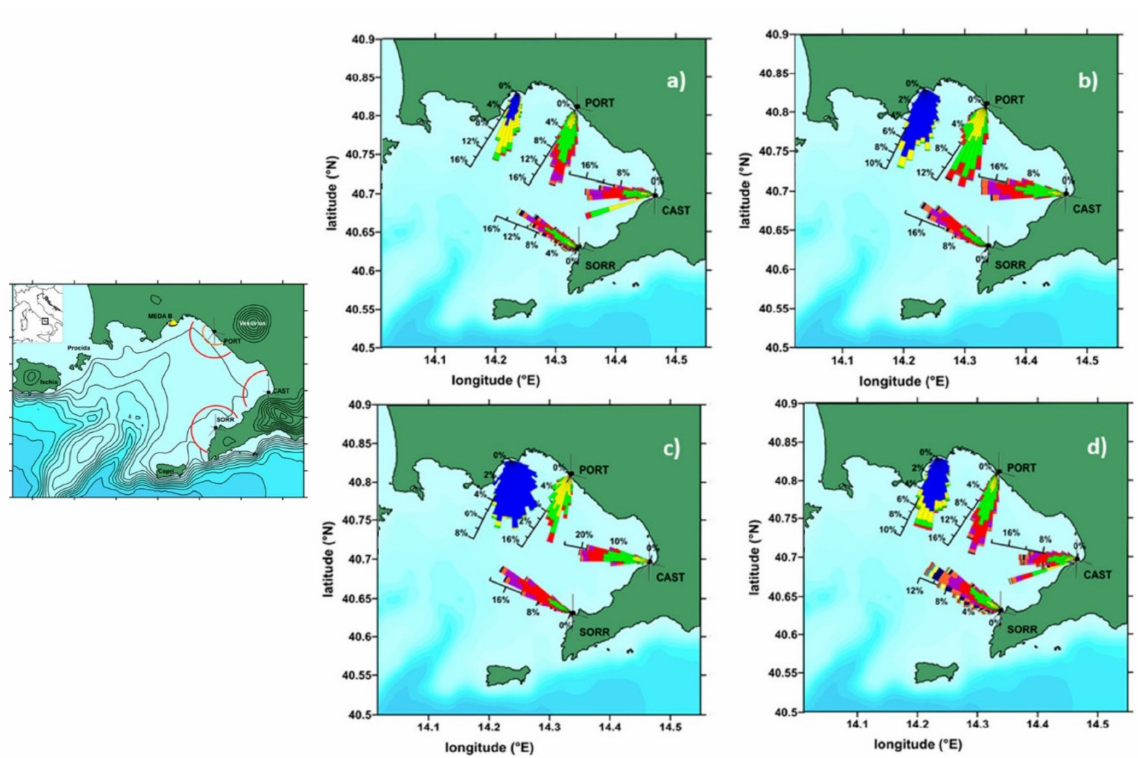
Figure 6. Seasonal rose diagrams for the waves measured between May 2008 and December 2012 by three HF radar stations installed in the Gulf of Naples, and between November 2015 and De- cember 2018 by an ADCP mounted on a MEDA elastic beacon: ( a ) winter; ( b ) spring; ( c ) summer; and ( d ) autumn (the maps show the locations of the different instruments and the extension of the range cell utilized around the radar antennas). Adapted from